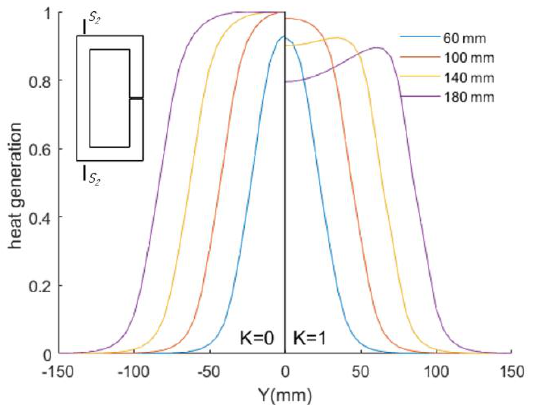
Figure 14. Heat generation in section S 2 –S 2 .